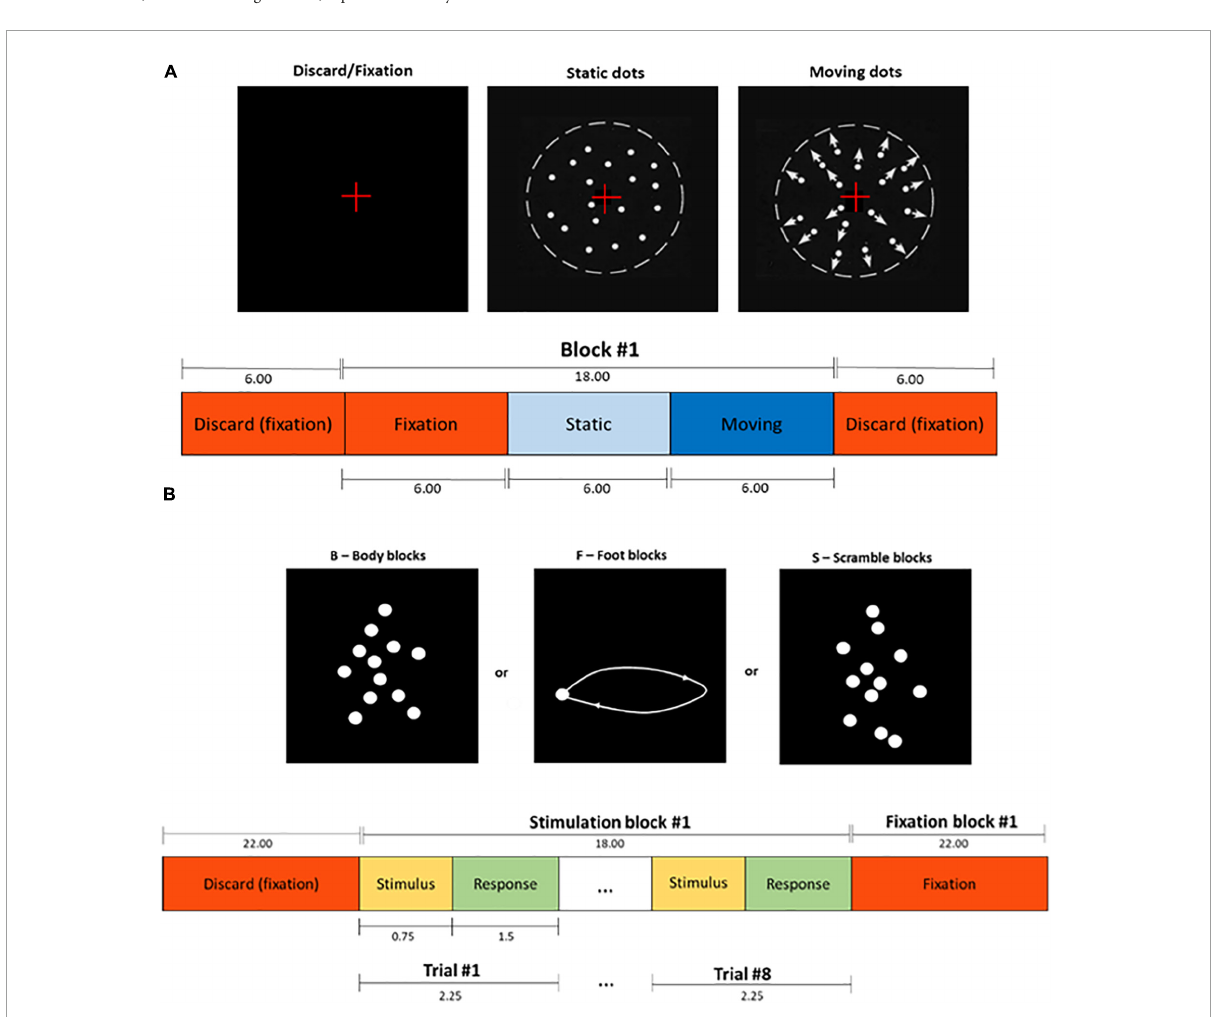
FIGURE1 (A) Schematic representation of the functional localizer task. The duration of each period is indicated in seconds. Adapted from Huk and Heeger (2002). (B) Schematic representation of the biological motion (BM) task. The duration of each period is indicated in seconds.